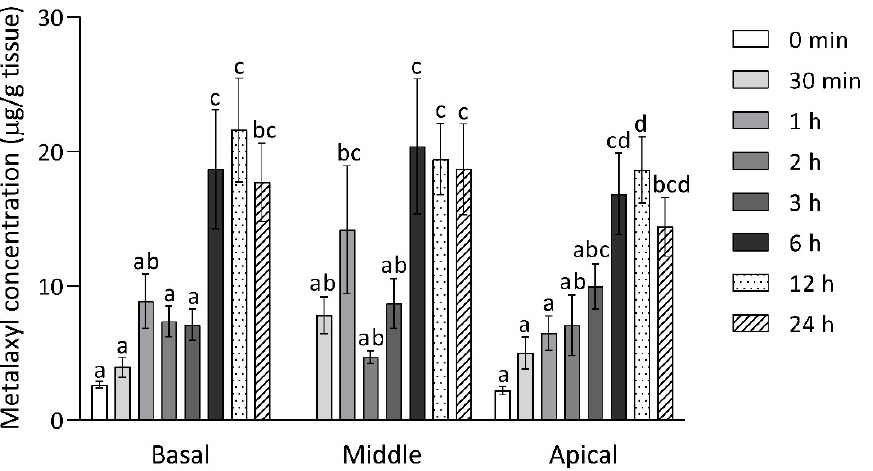
Figure 4. Metalaxyl concentrations in basal, middle, and apical parts of durian seedlings. The error bars represent the standard errors of nine replications from a pooled sample of 6–9 leaves from three seedlings. The bars in the same time point with the same letter designate no significant dif- ference at p < 0.05 using ANOVA with Duncan’s multiple range test.